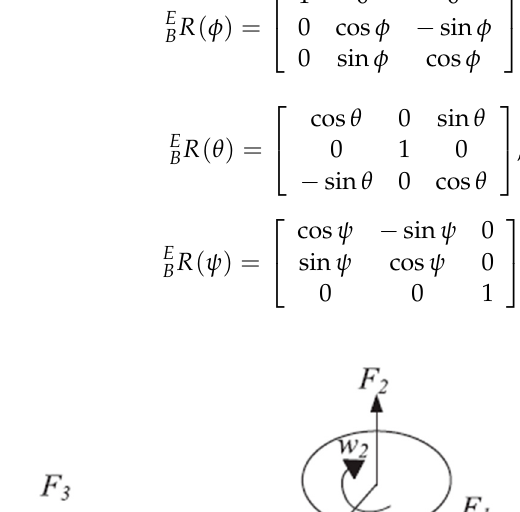
Figure 1. Leader trajectory tracking control system structure.